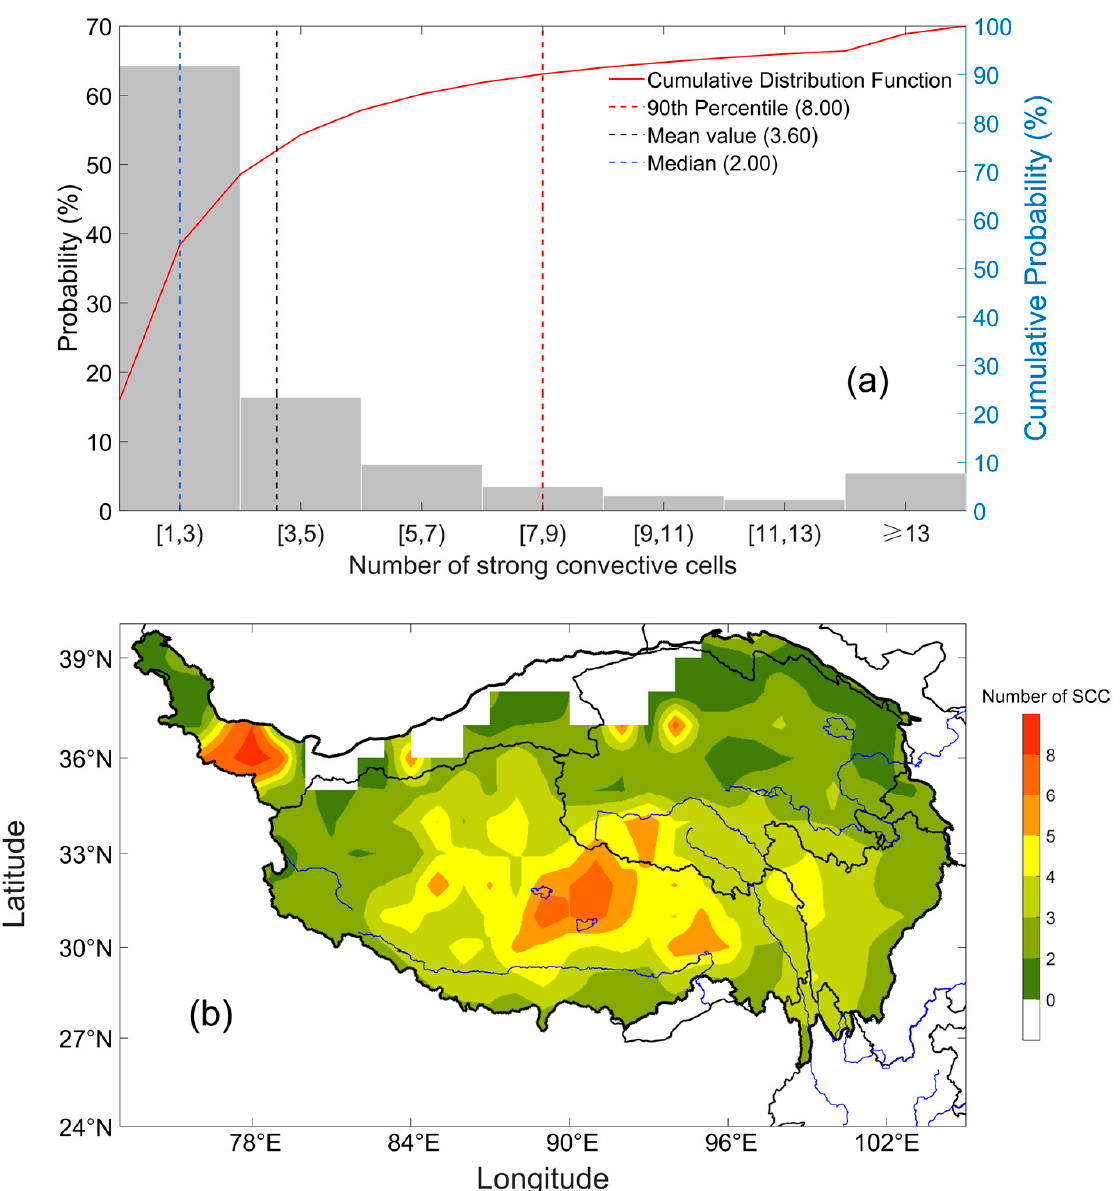
Figure 8. Probability and cumulative probability distribution ( a ) and spatial distribution ( b ) of the number of SCCs of thunderstorms over the QTP during the warm season (from May to September). In ( b ), the statistical grid size is 1° × 1°. Figure 9b shows the spatial distribution of the area ratio of SCCs. The values greater than 30% were mainly distributed in the northeastern QTP and the central and eastern areas of the southern QTP, covering the three centers with high-frequency thunderstorm activity. The northeastern QTP had the largest area ratio of SCCs, with the values in some local regions exceeding 40%, which may mean that the thunderstorms in the northeastern QTP tend to have stronger